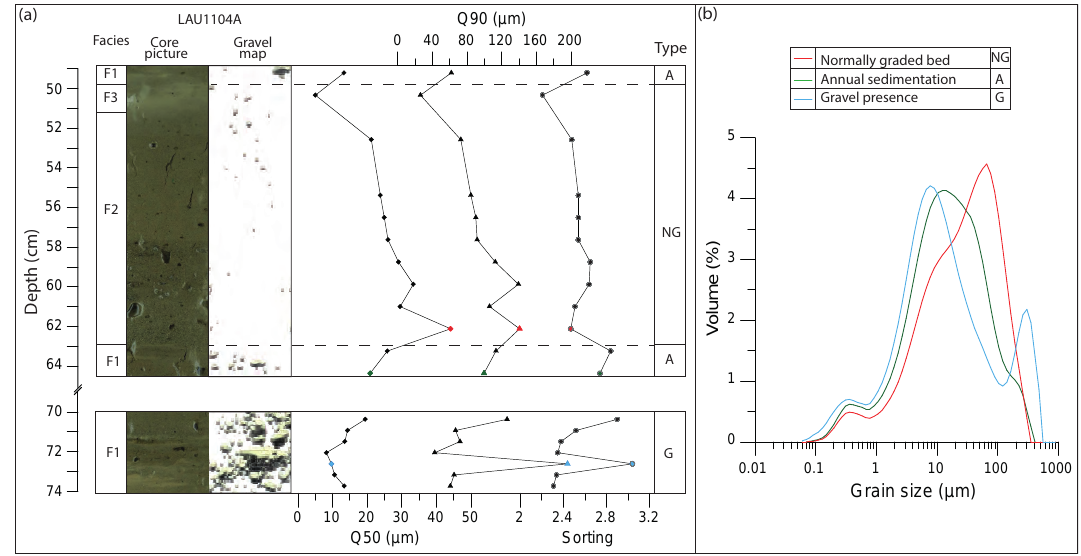
Figure 2. (a) Characterization of typical facies of LAU1104A sediment core, based on median grain size (Q50), 10th percentile coarse grains (Q90) and sorting parameters. (b) Comparison between NG, normally graded bed base sample (red line); A, annual sedimentation (green line); and G, gravel presence (blue line) grain size